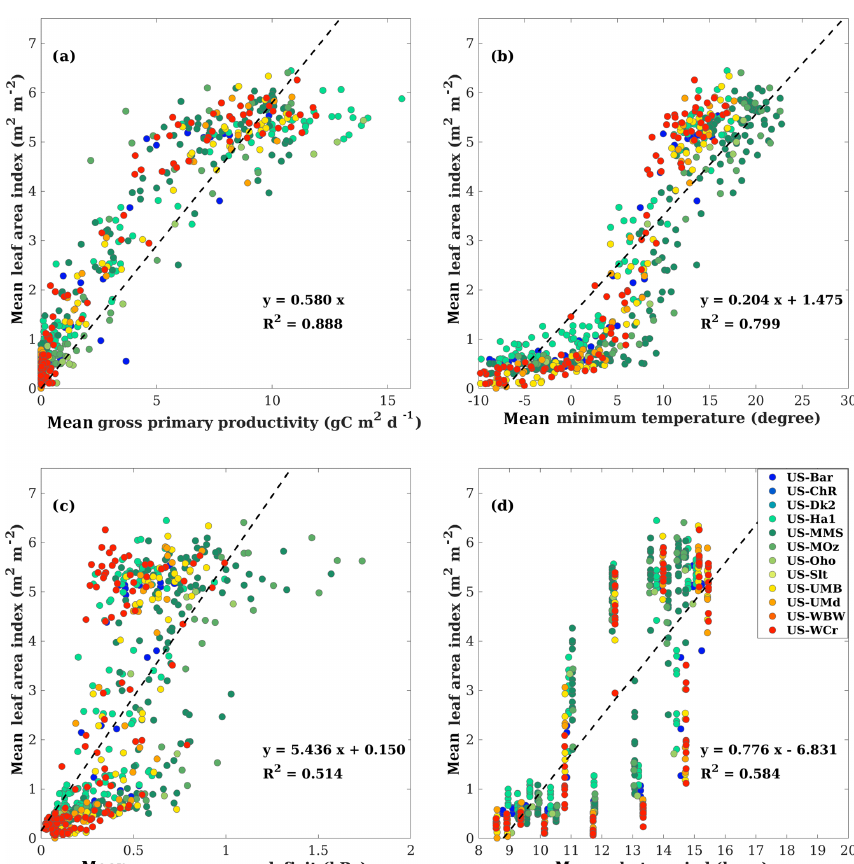
Figure 8. Scatter plots are shown for the relationship (a) between mean leaf area index and mean gross primary production, (b) between mean leaf area index and mean temperature, (c) between mean leaf area index and mean vapor pressure deficit, and (d) mean leaf area index and mean photoperiod on a monthly basis. All available site-year flux tower data were included in the analysis. All data were averaged to the monthly timescale for analysis, making the point numbers different from the analysis at the weekly timescale in Fig. 2. The dashed lines denote the regression lines. Panel (a) uses the regression without